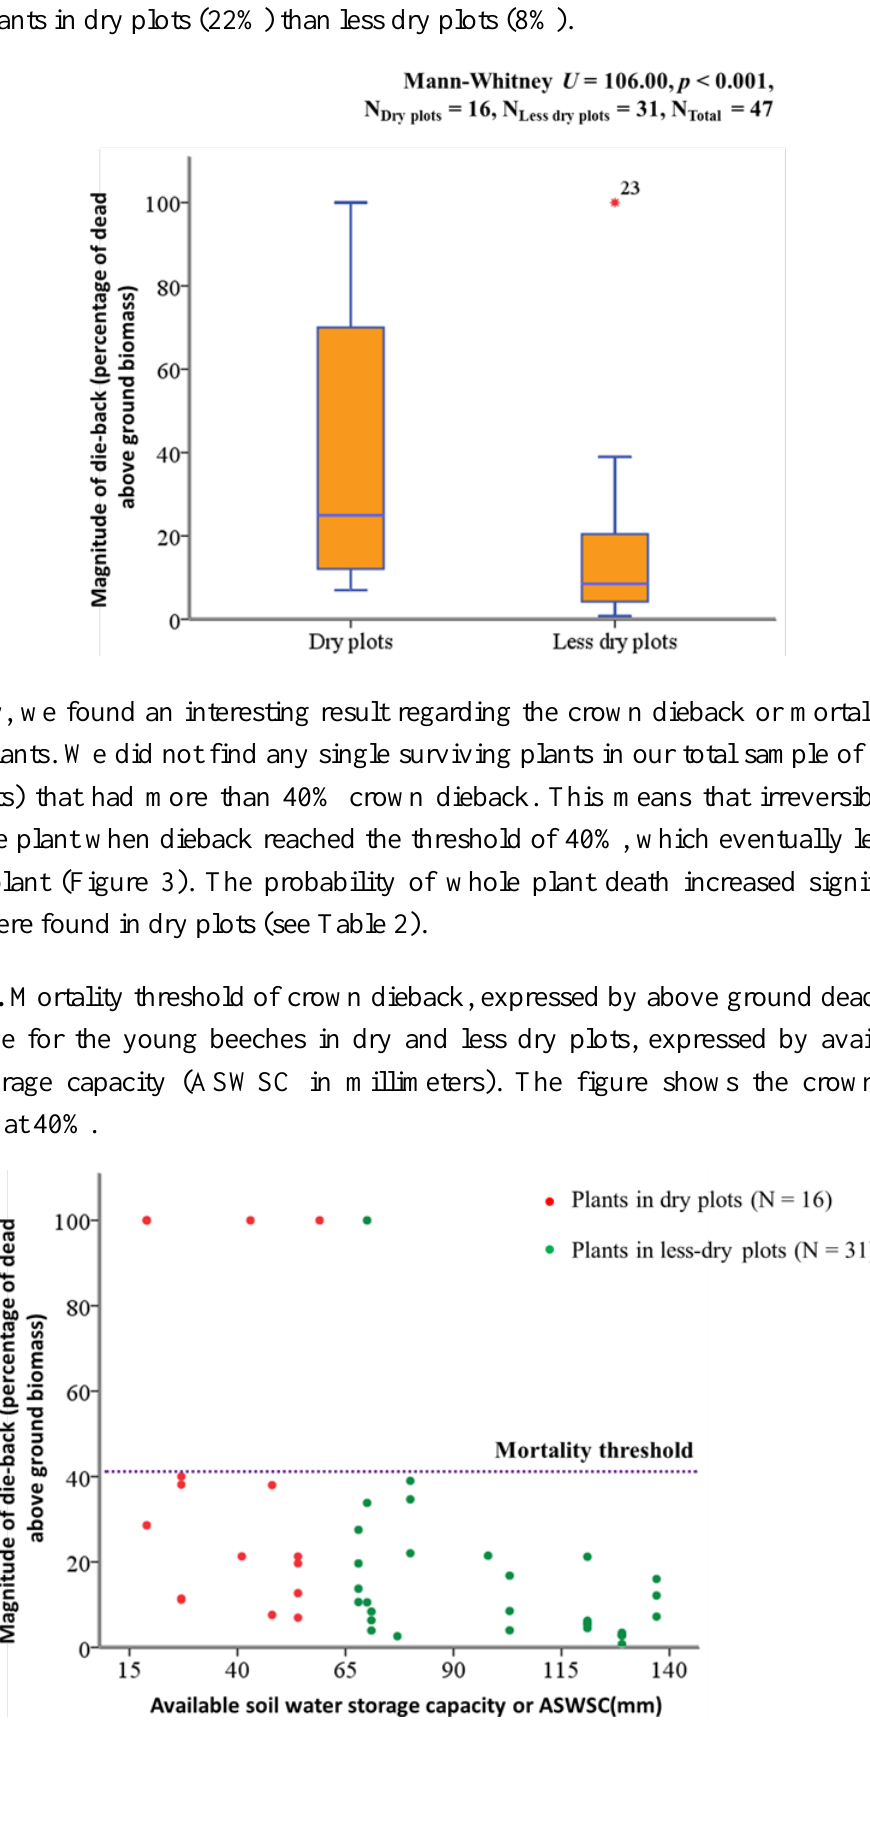
Figure 2. Magnitude of crown dieback (reported as median) was significantly higher among plants in dry plots (22%) than less dry plots (8%).